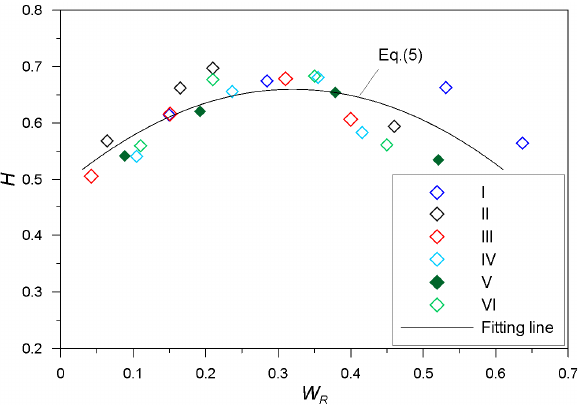
Figure 6. Empirical relationship between harmony ( H ) and amount of visible water ( W R ).